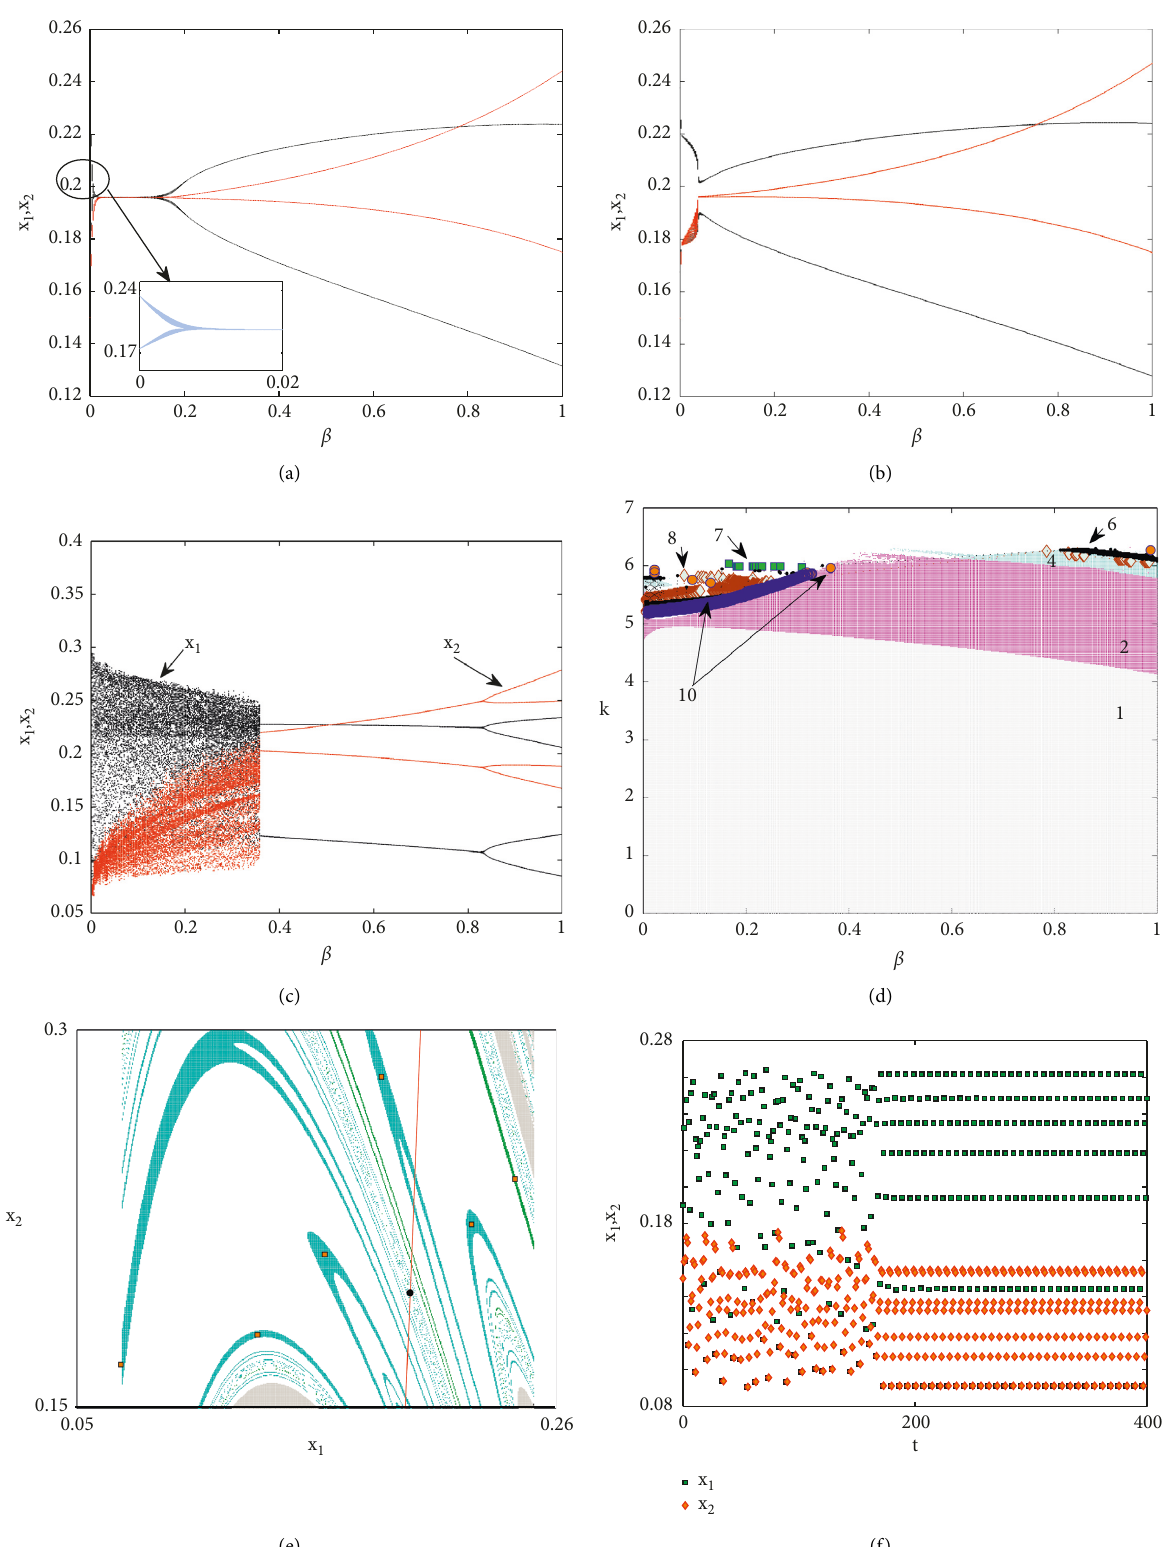
Figure 3: (a) Bifurcation diagram at varying the parameter β . (b) Bifurcation diagram at varying the parameter β and k � 5 . 09. (c) Bifurcation diagram at varying the parameter β and k � 6. (d) 2D Bifurcation diagram at ω � 0 . 5 , c (e) The basin of attraction of stable period 6-cycle. (f) The time series for the periodic